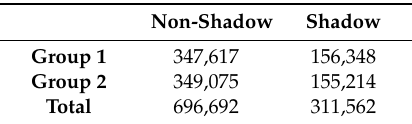
Table 4. Number of data for 2-fold cross validation in our